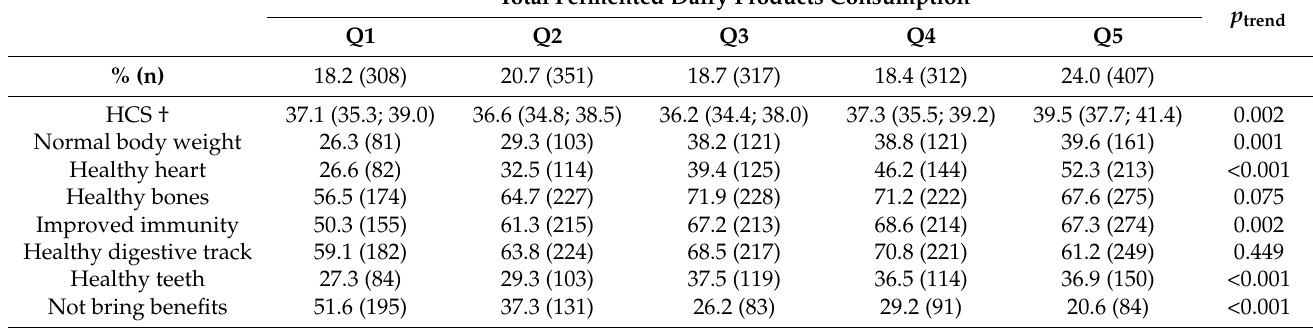
Table 3. Association of health concern scale and health beliefs with total fermented dairy products consumption.